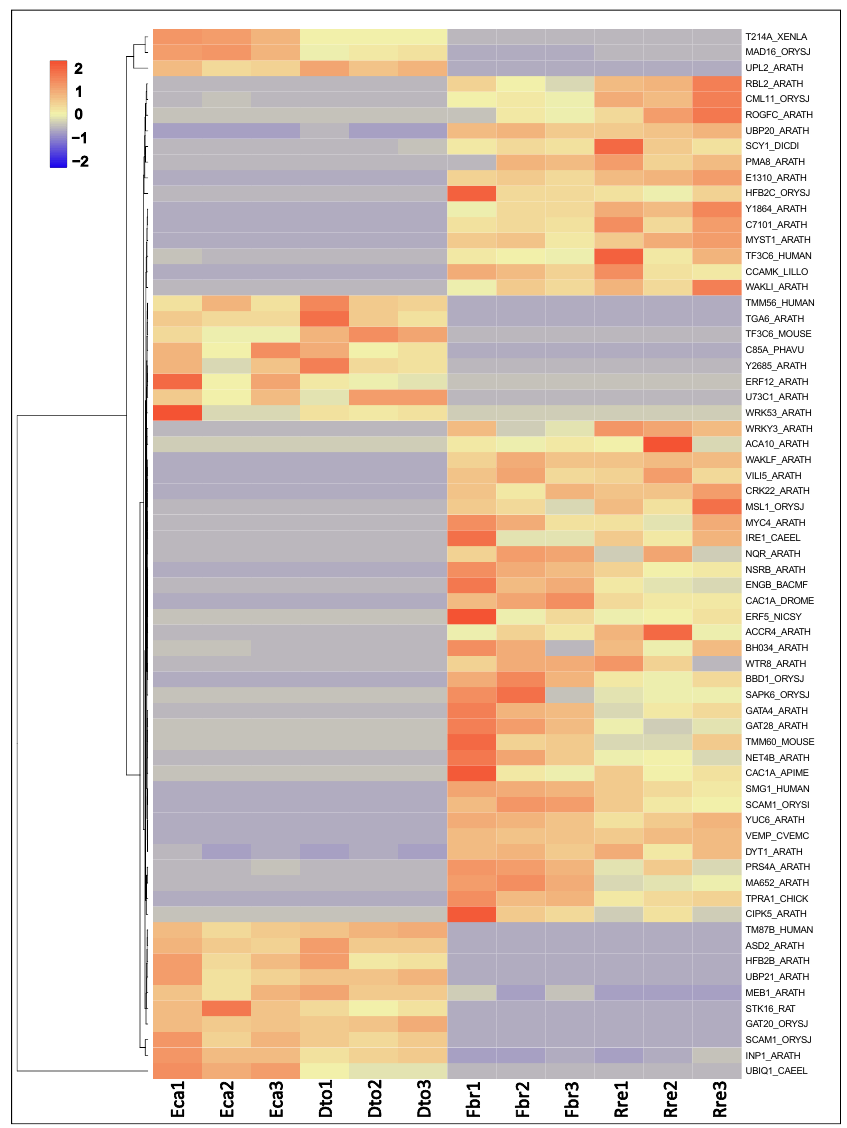
Figure 6. Heatmap of DEGs between colpate and porate species selected as potentially involved in the determination of pollen aperture shape. The heatmap scale bars indicate log 2 fold changes. Eca, Eschscholzia californica ; Dto, Dactylicapnos torulosa ; Fbr, Fumaria bracteosa ; Rre, Roemeria refracta .